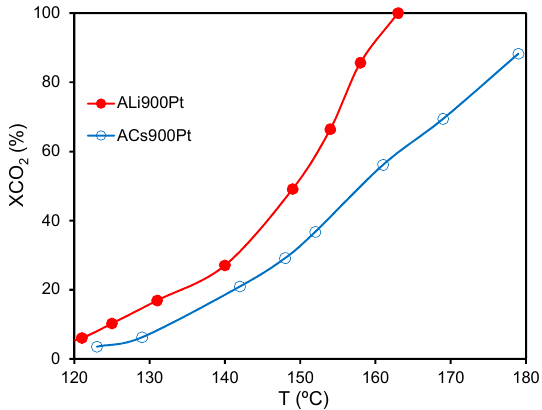
Figure 5. Influence of the macro-mesoporosity of supports on the benzene catalytic combustion ([benzene] = 1000 ppm, Q = 3.6 L h − 1 , 0.10 g catalyst ). Figure adapted with permission from [61]. Copyright 2010,